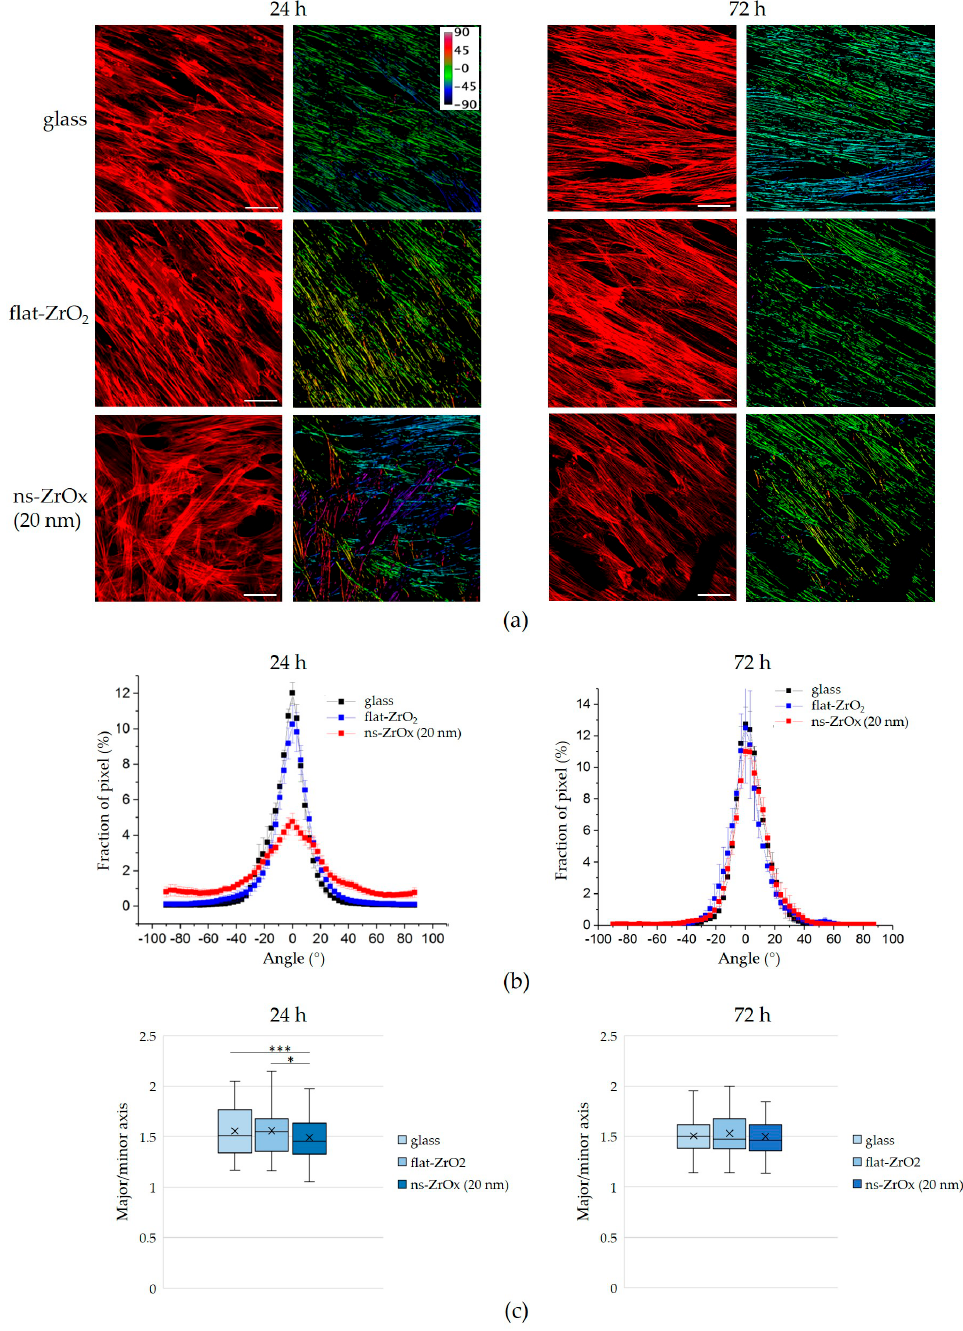
Figure 6. The effect of 20 nm ns-ZrOx on the organization of actin fibers and nuclear architecture. Figure 6 . The effect of 20 nm ns ‐ ZrOx on the organization of actin fibers and nuclear architecture. bMSCs were cultured on 20 nm ns-ZrOx, flat-ZrO 2 , and glass for 24 and 72 h. ( a ) The respective bMSCs were cultured on 20 nm ns ‐ ZrOx, flat ‐ ZrO 2 , and glass for 24 and 72 h. ( a ) The respective orientation analysis of actin fibers was performed using ImageJ. The images in the left panel were obtained via confocal microscopy; the images in the right panel represent the respective orientation analysis obtained using ImageJ. Actin fibers of the same color indicate a well-oriented and organized cytoskeleton. In contrast, actin fibers with different colors indicate the presence of randomly organized fibers. Scale bar: 50 µ m. ( b ) The graphs show the angle distribution of actin fibers in the range of − 90 ◦ to +90 ◦ around the most represented angle. ( c ) Analyses of nuclear architecture (major/minor axis). * p ≤ 0.05; *** p ≤